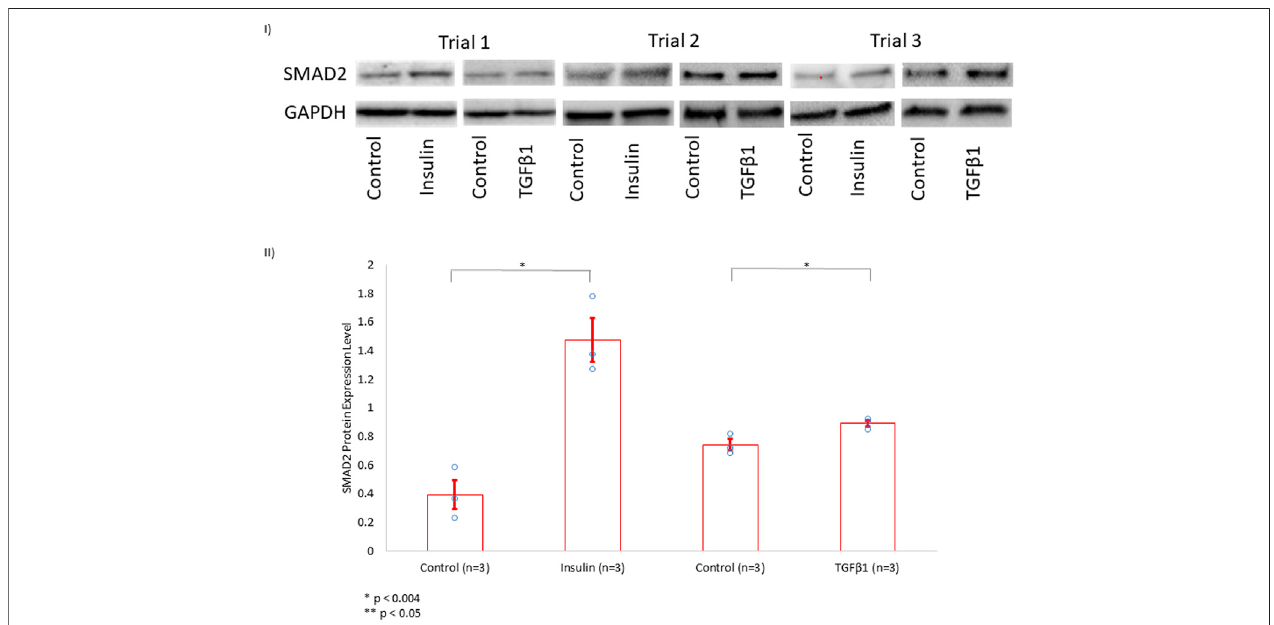
FIGURE 5 | SMAD2 Protein Expression Level in HCF Treated with Insulin or TGF β 1. (I) In the presence of growth media, HCF were treated separately with control solution,insulin(10 nmol/L),orTGF β 1(5 nmol/L)for72 h.Subsequently, SMAD2proteinexpression levelwasassessedusingWesternblotting,withGAPDHservingas a control for normalization. These experiments were done in triplicates (Trials 1, 2, and 3). (II) Band intensities were quanti fi ed using ImageJ software. Insulin increased SMAD2 protein expression level to more than 3.5 × when compared to controls. TGF β 1, serving as a positive control, also increased SMAD2 expression.